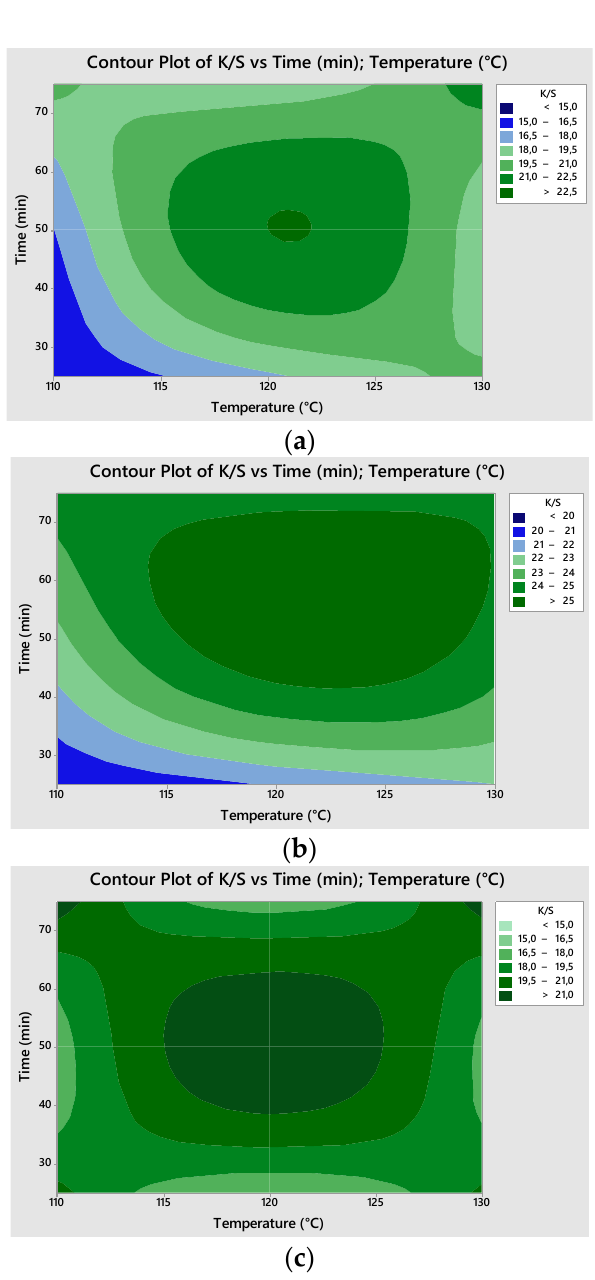
Figure 13. Surface plots for color yield (K / S) of bicomponent filaments dyed with: ( a ) Dye #H; ( b ) Dye #M; ( c ) Dye #L.